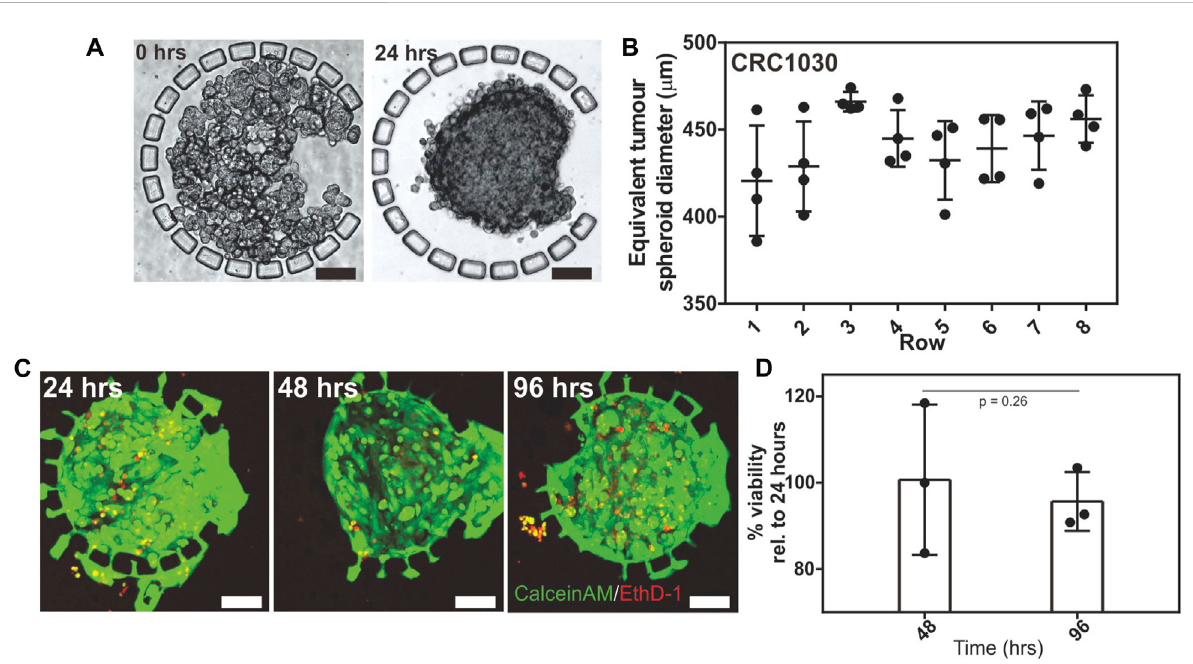
FIGURE 2 Seeding and perfusion culture of PDX derived tumour spheroids within the IMITA device. Transmission images showing: (A) CRC1030 PDX derived tumour cells seeded and trappedbythe micropillar arrayin thecell culture chamber; (B) seeded cells remodelled into a3D tumour spheroid after 24 hof perfusion culture. Scale bars = 100 µm; (C) Quanti fi cation of PDX derived tumour spheroid size distribution across all rows of the IMITA device after 24 h of perfusion culture (One-way ANOVA, p = 0.0891). The spheroid ’ s equivalent diameter was estimated from the spheroid ’ s area; (D) Live (CalceinAM, green)-dead (EthD-1, red) staining of the seeded PDX derived tumour cells within the IMITA device after 96 h of perfusion culture. Scale bar = 100